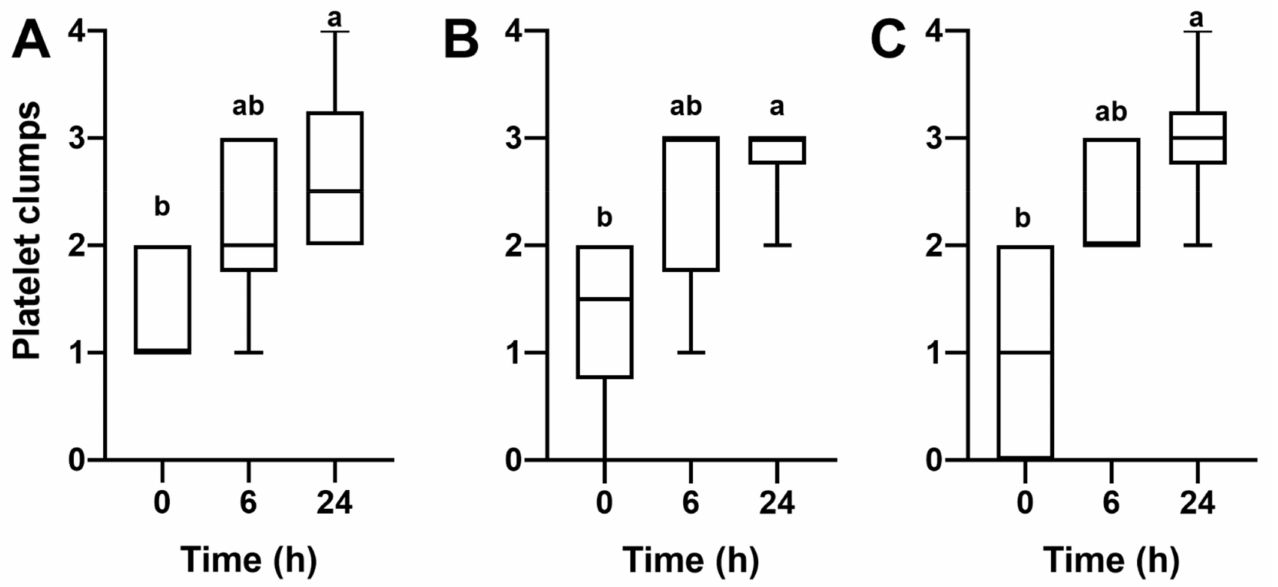
Figure 4. Presence of platelet clumps in PRP of six mares, having WB harvested and processed by 3 methods to prepare PRP for intrauterine infusions in mares and cooled-stored at 5 ◦ C for up to 24 h. ( A ) Method 1 consisted of collecting WB in a blood transfusion bag, centrifugation of WB at 400 × g /10 min (F-C), and centrifugation of plasma at 1000 × g /10 min. ( B ) Method 2 consisted of one centrifugation at 120 × g /10 min. ( C ) Method 3 consisted of collecting WB in a syringe and then letting it sediment in an upright position for 4 h. After processing (0 h), PRP was obtained across methods and cooled-stored at 5 ◦ C for 6 and 24 h. Platelet, WBC, and RBC counts and platelet viability were assessed in fresh (0 h) and cooled-stored PRP at 6 and 24 h. Clumps classification: score 0, absence of platelet clumps; score 1 , small platelet clumps identified in the hemocytometer chamber, but not within the squares used to obtain the platelet count; score 2 , small platelet clumps (~2–5 platelets/clumps) occurring in low numbers throughout the chamber and within the squares used for counting; score 3 , presence of low numbers of larger platelet clumps (~5–20 platelets/clump), or high numbers of small platelet clumps; score 4 , presence of many large platelet clumps. Differences within column superscripts ( a,b ) indicate differences between groups ( p <